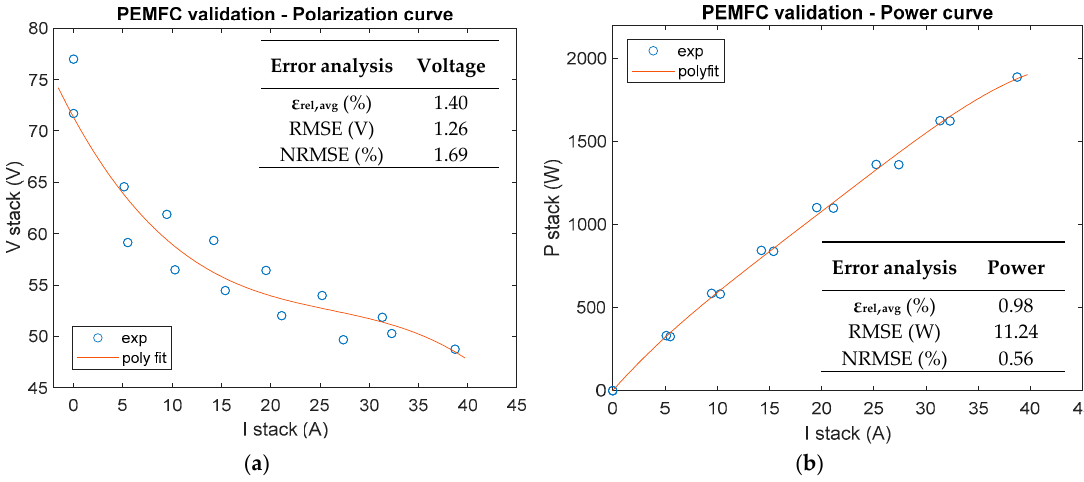
Figure 10. ( a ) Fuel cell polarization curves. Experimental data vs. polynomial fitting model; ( b ) Fuel cell power curves. Experimental data vs. polynomial fitting model.